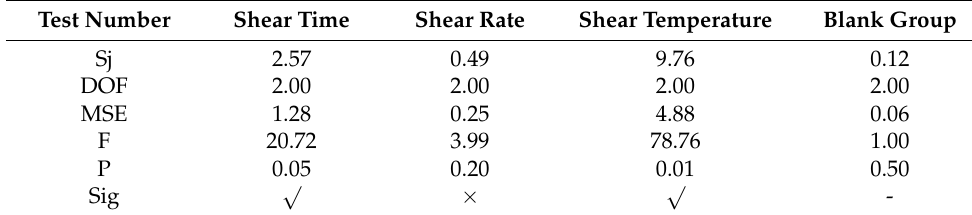
Table 10. Softening point variance